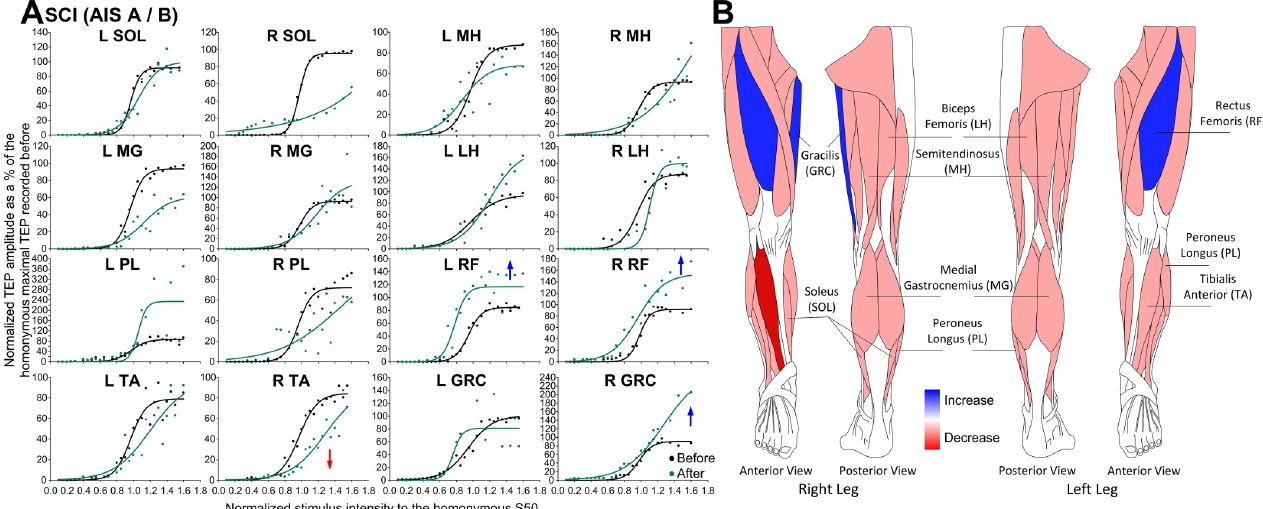
Fig 3. Transspinal evoked potential (TEP) recruitment curves before and after transspinal stimulation in AIS A-B. (A) TEPs normalized to the homonymous maximal TEP and plotted against normalized stimulation intensities to the S50-TEPmax obtained before transspinal stimulation training along with the sigmoid function fitted to the data. (B) Schematic representation of changes observed in the TEP recruitment input-output curves where red represents an increase and blue represents a decrease in the corresponding muscle from which the TEP was recorded. SOL: soleus; MG: medial gastrocnemius; TA: tibialis anterior; PL: peroneus longus; MH: medial hamstring; LH: lateral hamstring; RF: rectus femoris; GRC: gracilis. An asterisk indicates a significant difference before and after transspinal stimulation.